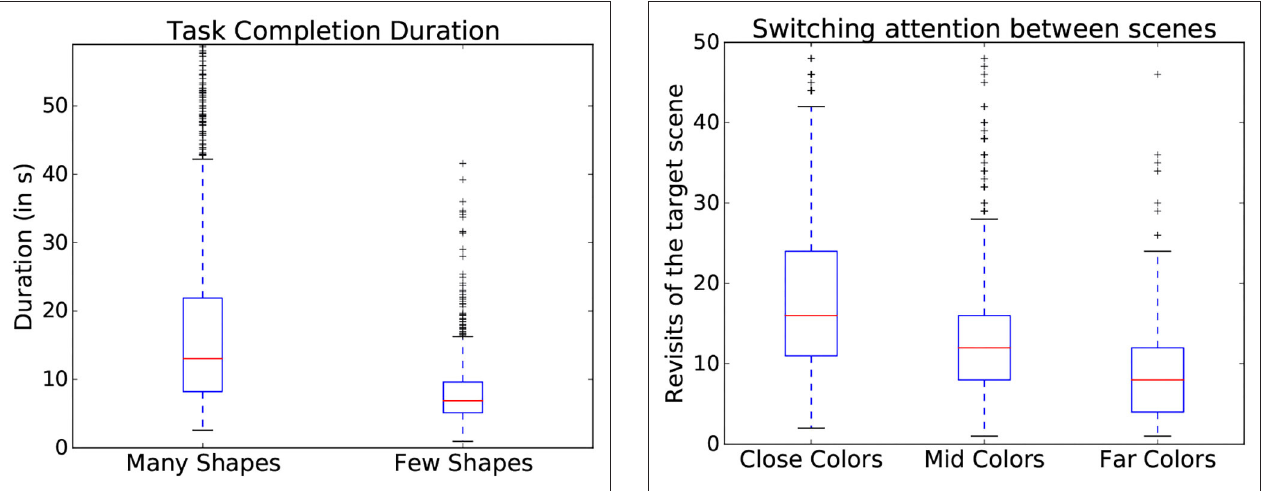
FIGURE 4 | Variation of task completion duration depending on the number of objects present in a scene. Data from all participants is used in this figure.